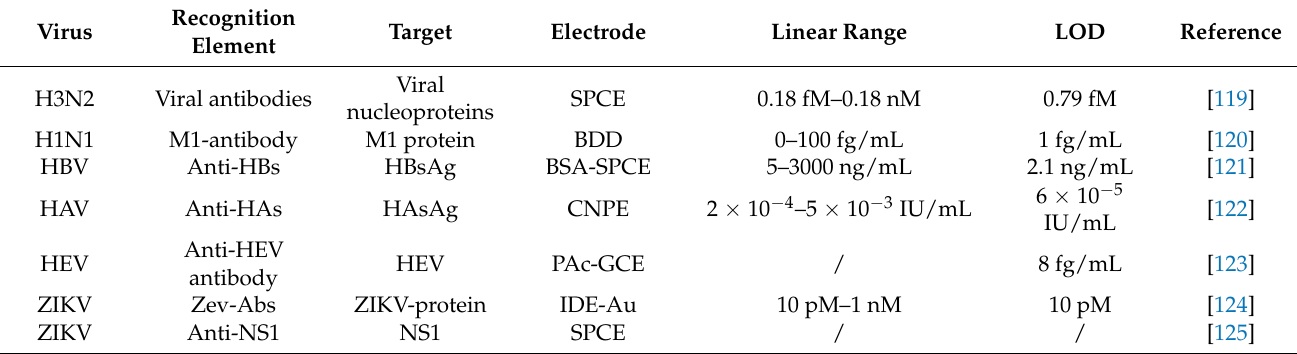
Table 3. Recently developed immunosensors for virus detection.